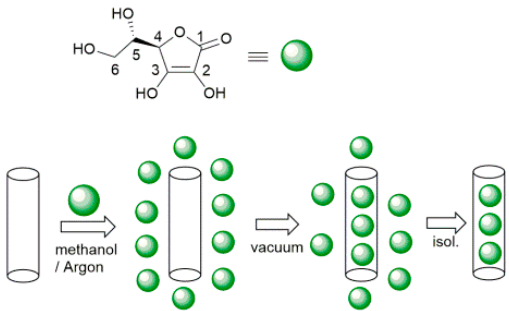
Figure 1 . ( A , B ) TGA (solid line) and derivative DTG (broken line) thermograms of: ( A ) ascorbic acid (AH 2 ) under air atmosphere at heating rate of 10° C/min; and ( B ) HNT ( ▬▬ ) and HNT/AH 2 ( ▬▬ ). The temperature profile applied during the measurement is reported. ( C , D ) DLS intensity distribution ofHNT (solid line) and HNT/AH 2 (broken line) ( C ) in acetonitrile; and ( D ) in water solution (0.5 mg/mL).